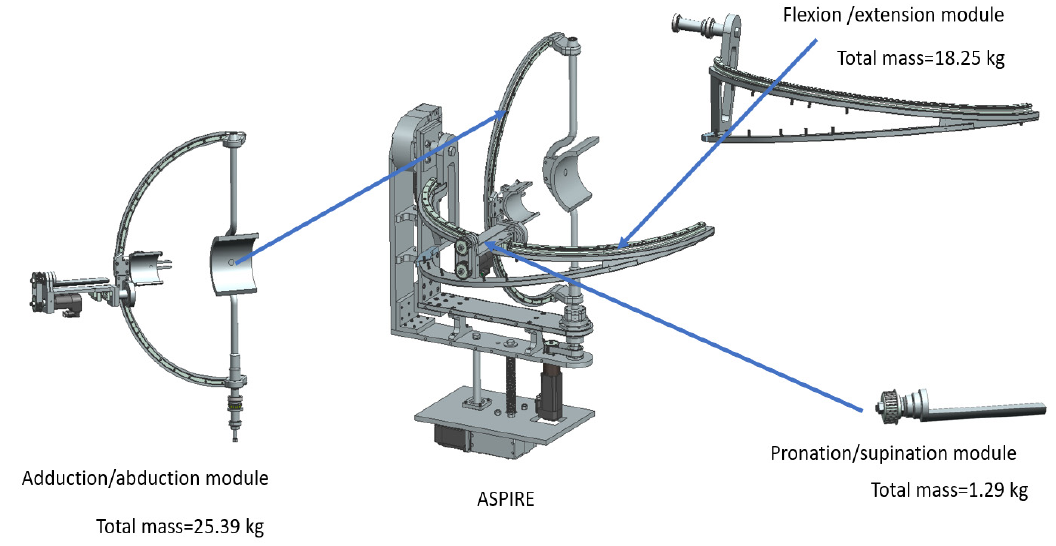
Figure 3. ASPIRE rehabilitation modules.